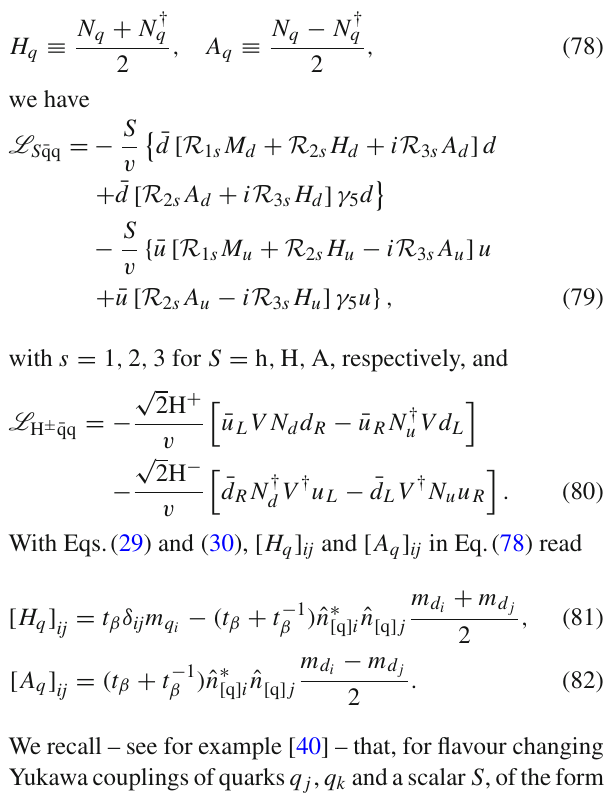
and the Yukawa couplings to the neutral and charged scalars = h, H, A, H ± . Introducing the hermitian and anti- L S ¯ qq , S hermitian